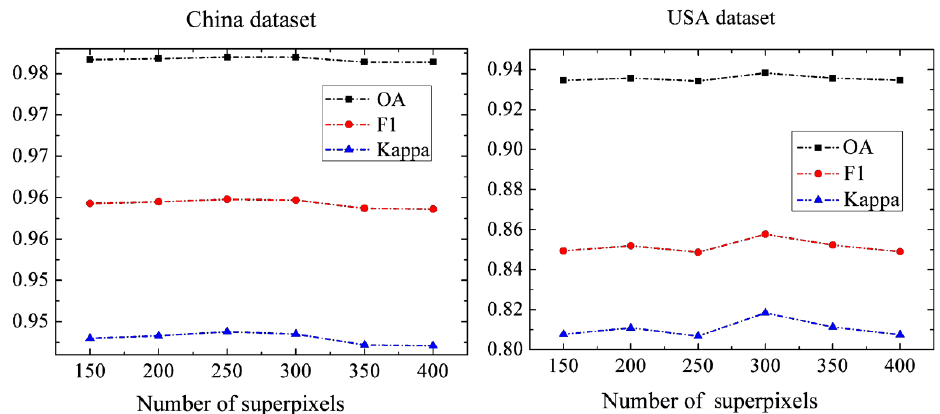
Figure 13. SSCF experiments using different numbers of superpixels.